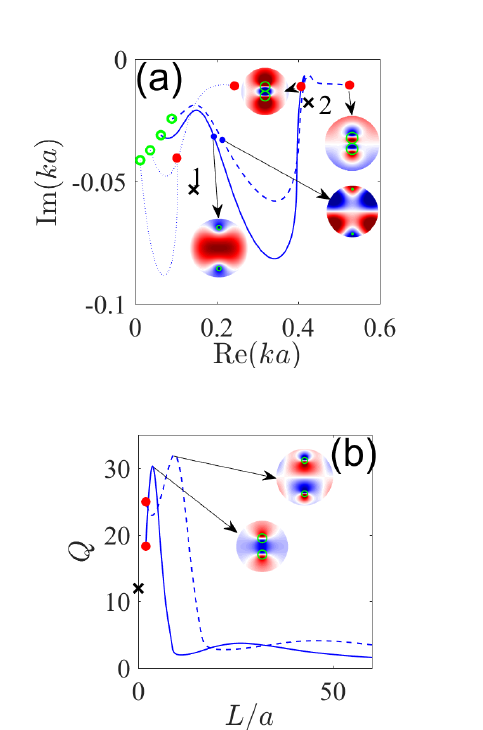
Figure 7: The same as in Fig. 6 for the dipole resonant modes ψ a ; s/a antisymmetric relative to x → − x